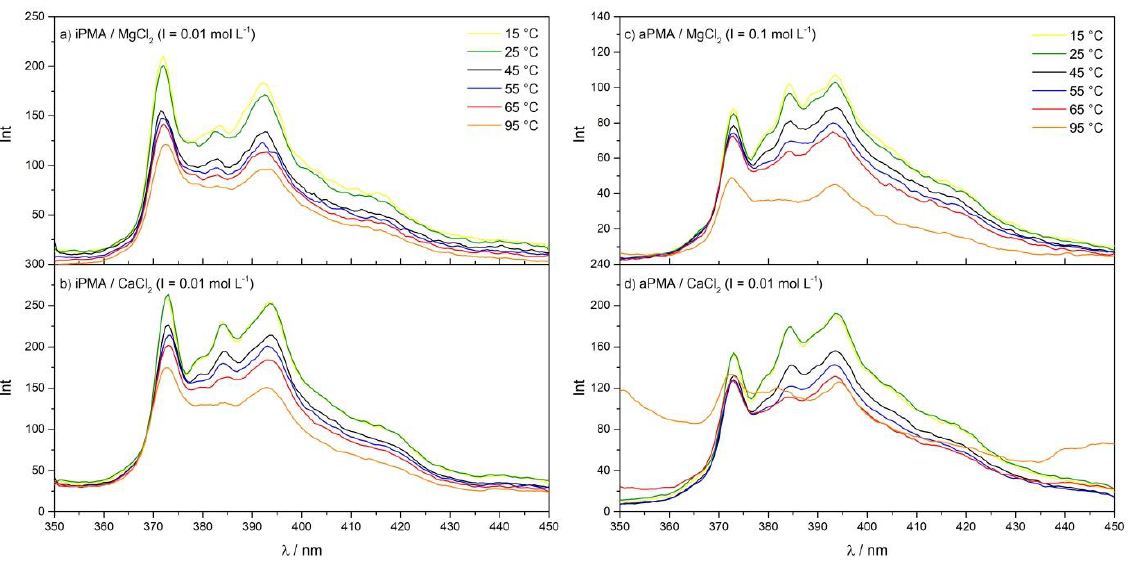
and b) 2 and d) CaCl 2 2 and CaCl with I 2 2